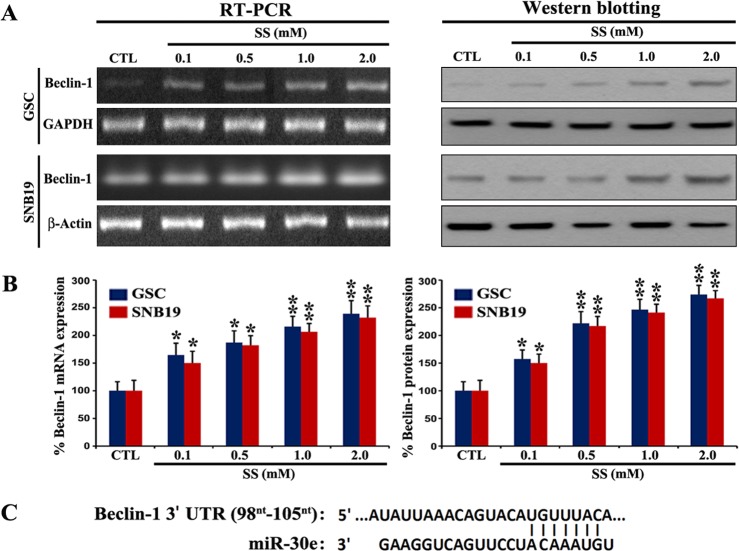
Changes in levels of expression of Beclin-1 in GSC and SNB19 cells corresponded with the miR-30e target prediction.(A) RT-PCR and Western blotting to determine relative expression of Beclin-1 mRNA and protein, respectively, in GSC and SNB19 cells after treatment with SS, as described in Fig 1 legend. (B) Quantitative analysis of Beclin-1 mRNA and protein from three independent experiments to present as bar diagrams. Significant difference between CTL and any treatment was indicated by *P < 0.05 and **P < 0.01. (C) Bioinformatics analysis showing Beclin-1 as a potential target for miR-30e.